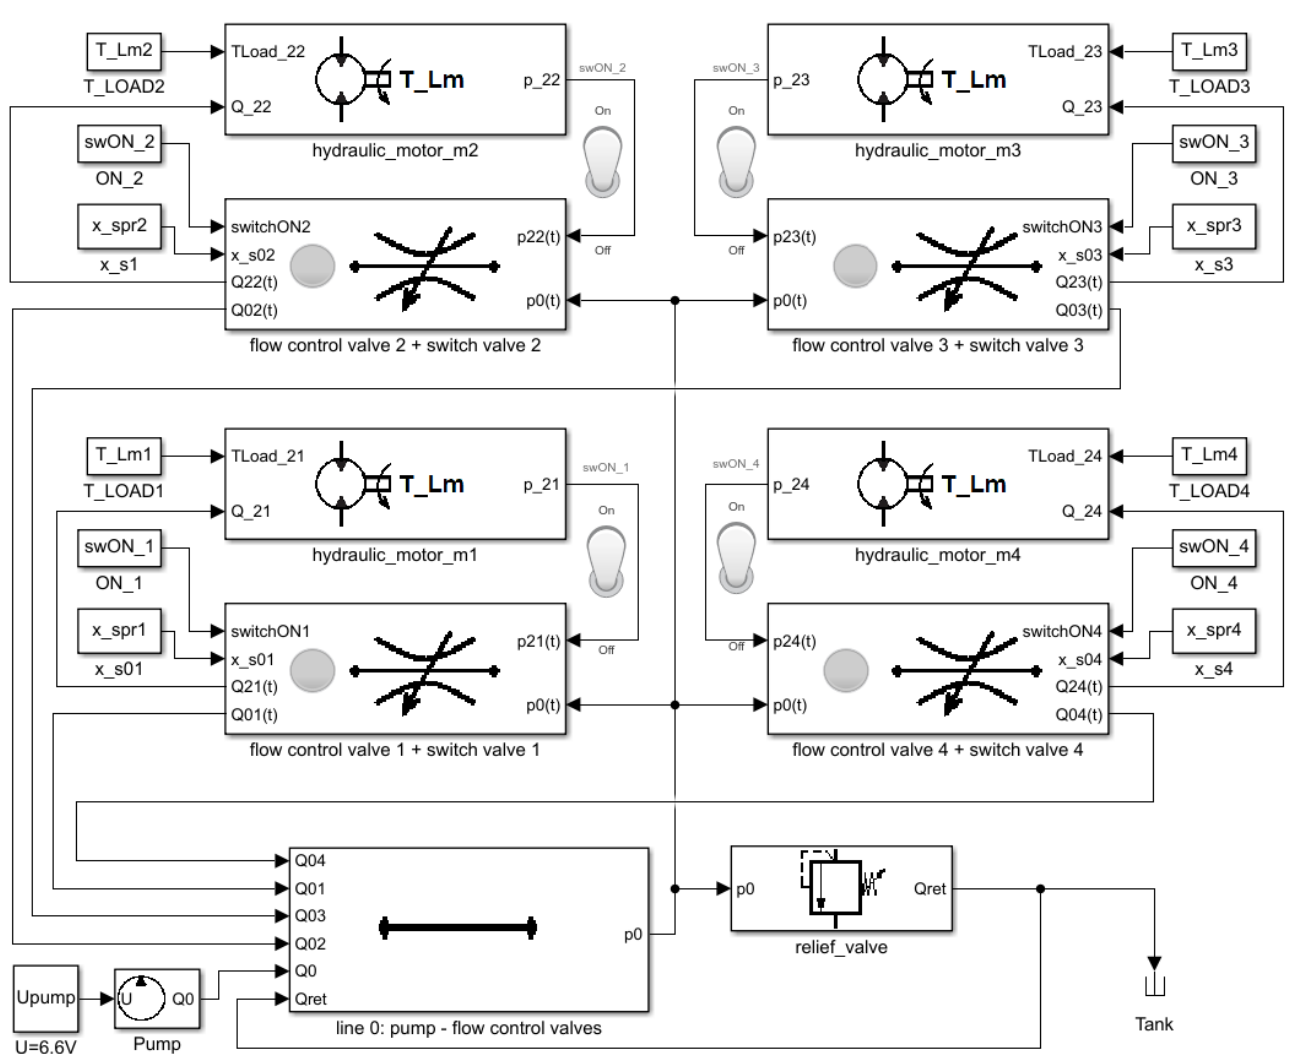
Figure 9. Simulink model of the hydraulic system.